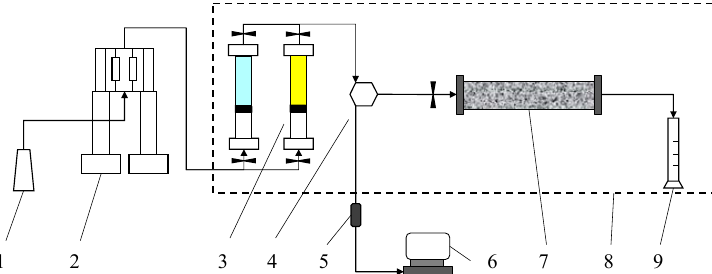
Figure 1. Schematic of sand-pack displacement experimental apparatus.